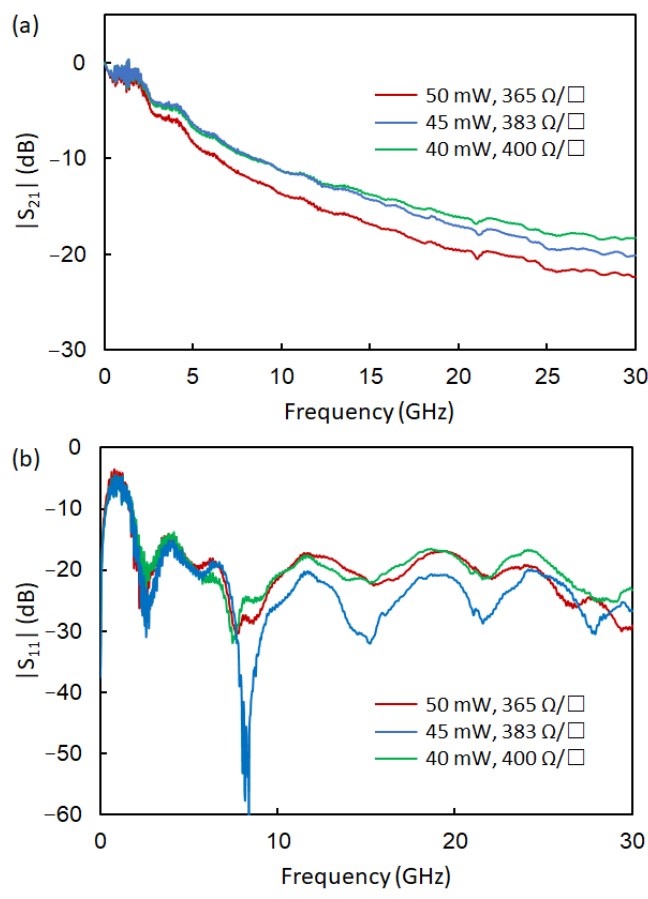
Figure 9. The measured S-parameters of the laser-scribed termination at two-port configurations, ( a ) transmissions |S 21 | and ( b ) reflections |S 11 |.